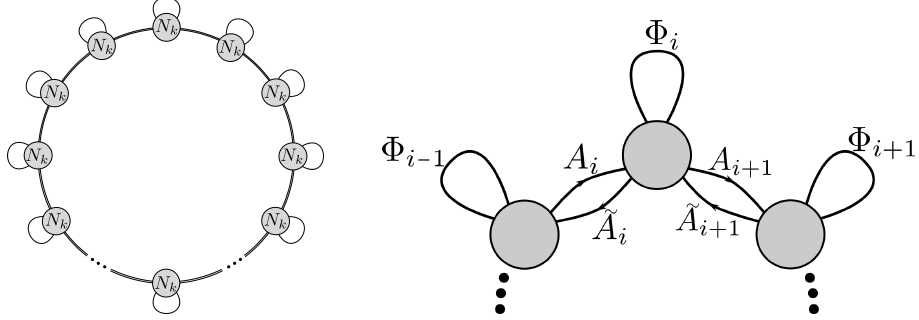
Figure 4: Left: A necklace quiver gauge theory with b nodes obtained by performing a Z orbifold of N = 4 SYM. Right: The quiver representation of the theory consists b of b gauge nodes, each with Chern-Simons level k , connected with a bifundamental hypermultiplet. In addition a chiral adjoint is attached to every